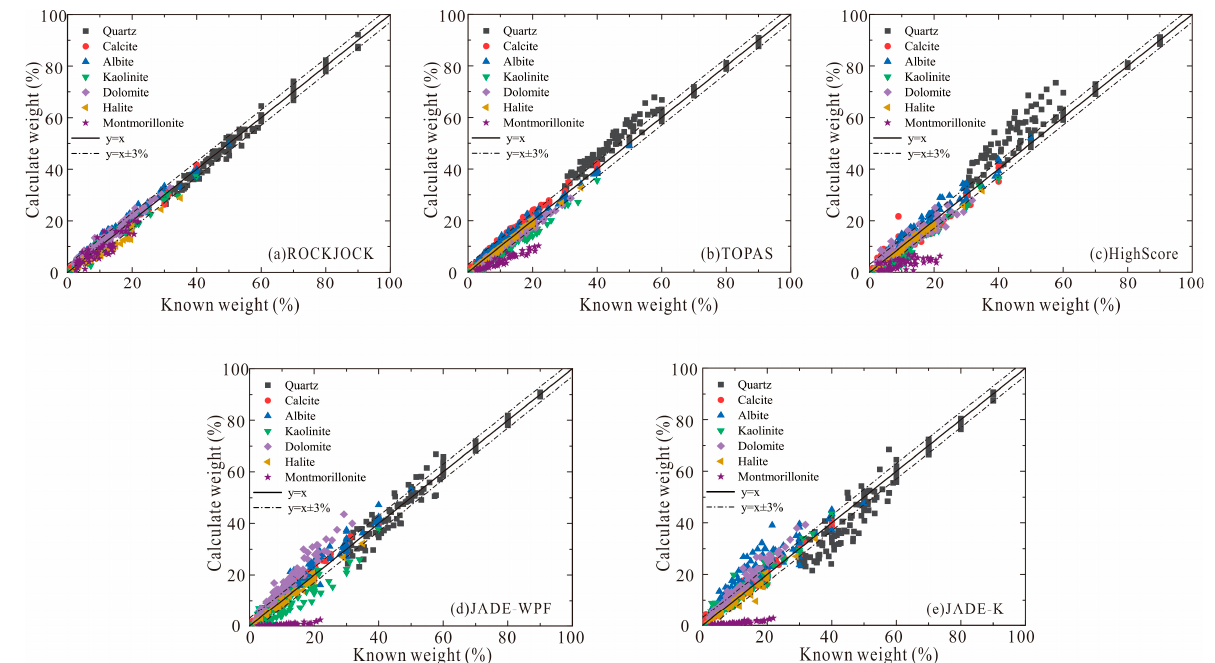
Figure 4. Comparisons of the known and calculated concentrations obtained by different methods. ( a ) for FPS method by ROCKJOCK; ( b ) for Rietveld method by TOPAS; ( c ) for Rietveld method by HighScore; ( d ) for Whole Pattern Fitting(WPF) and Rietveld Refinement by JADE; ( e ) for RIR method by JADE.